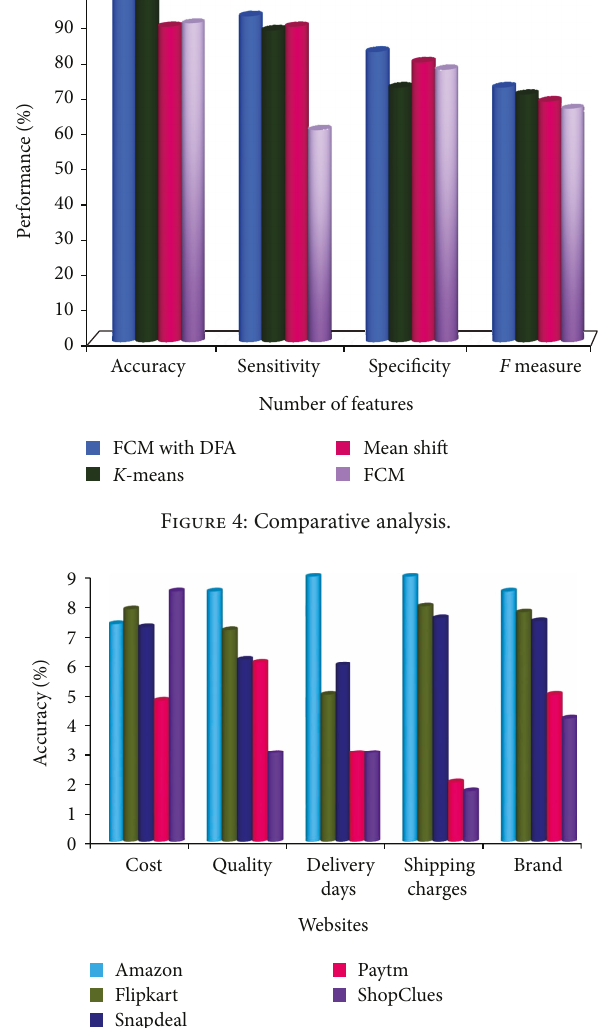
Figure 5: Ranking